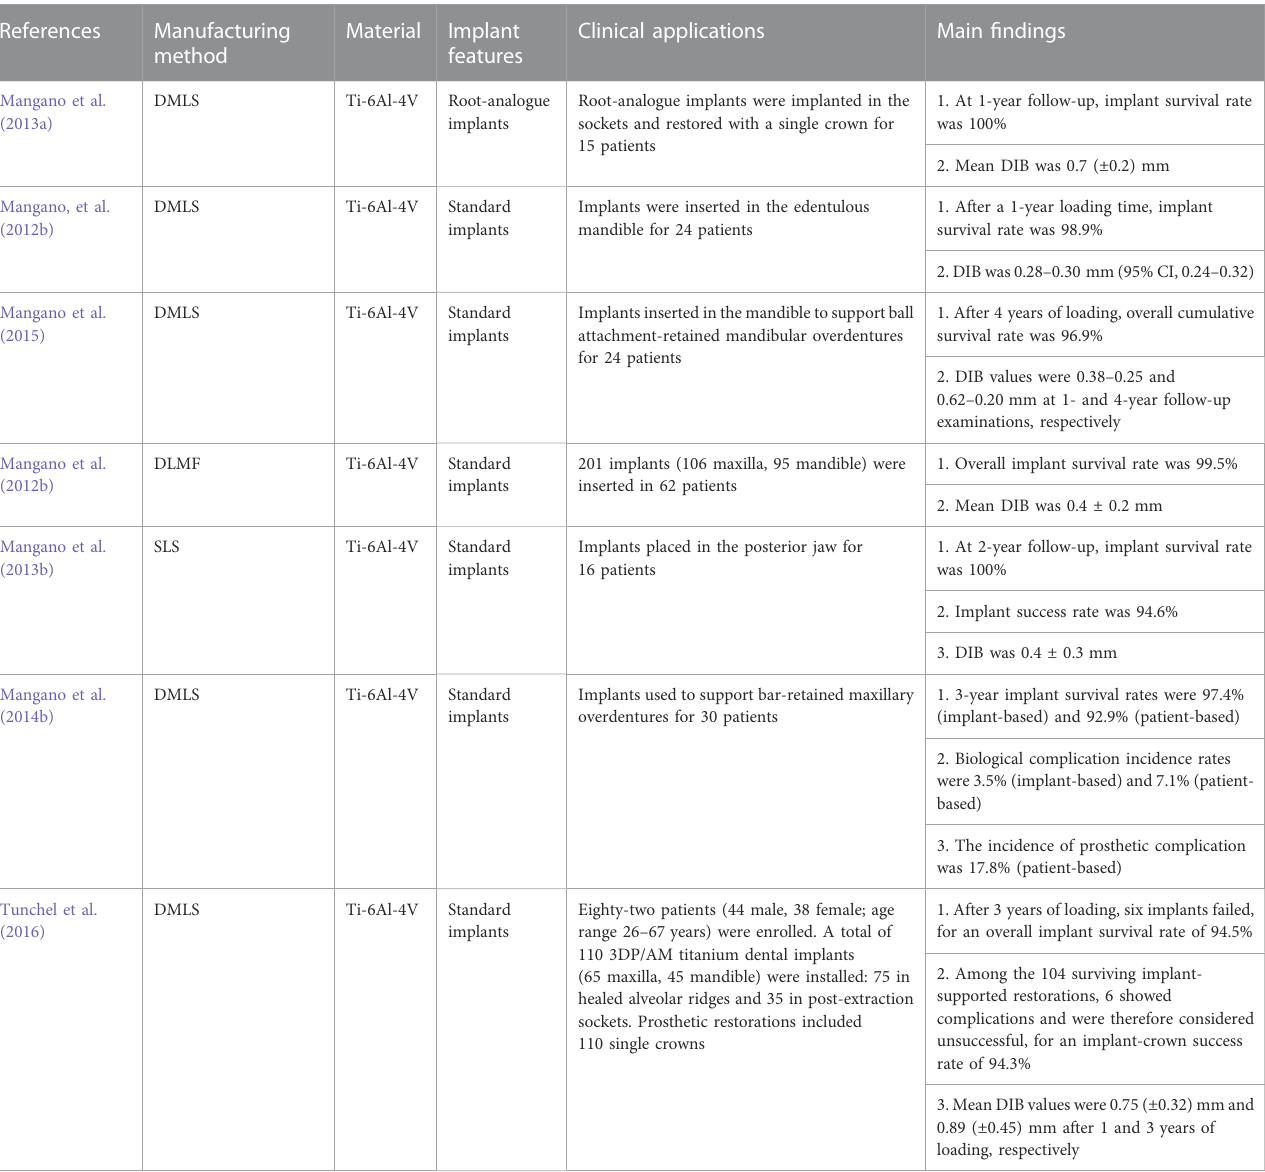
TABLE 3 Clinical studies of 3D printed titanium